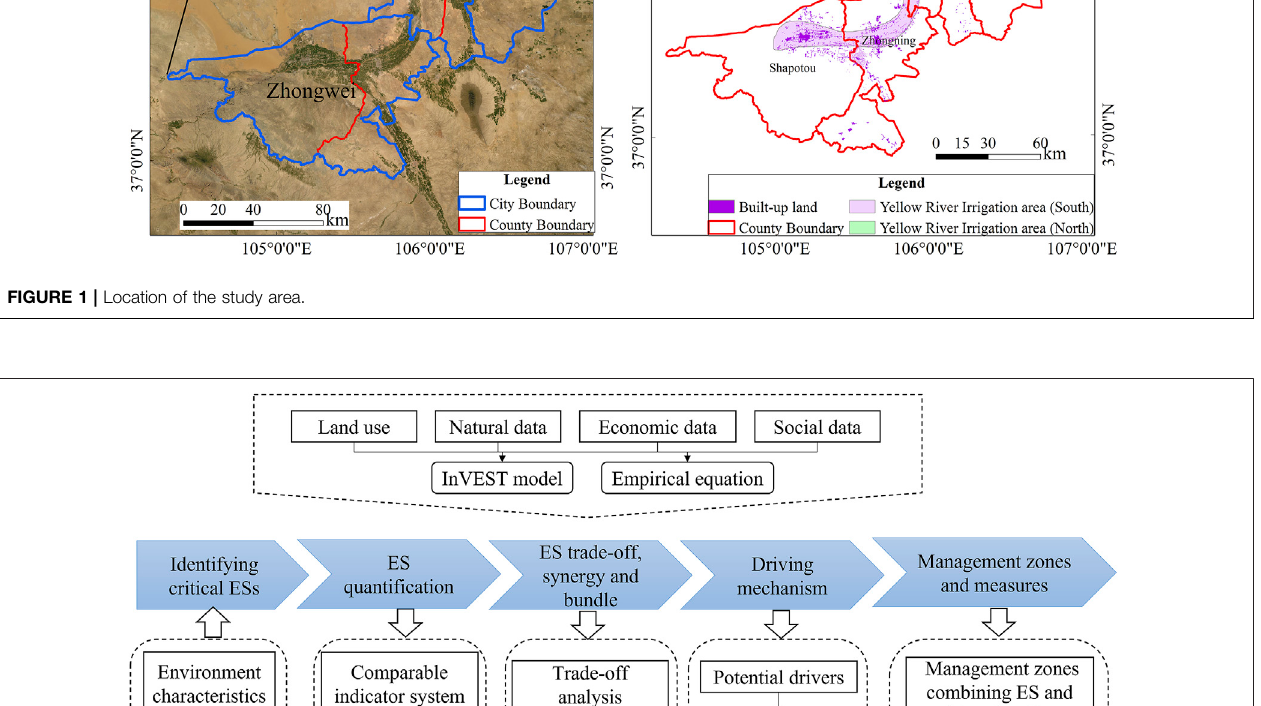
Frontiers in Environmental Science |